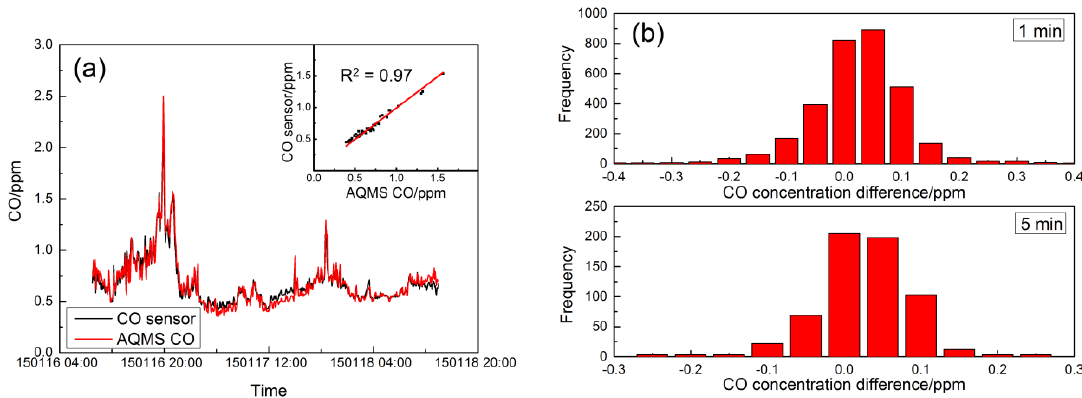
Figure 5. Comparison of the CO concentration from MAS and AQMS. ( a ) Time series of concentration; ( b ) histogram of the concentration difference in the 1-min and 5-min time average.